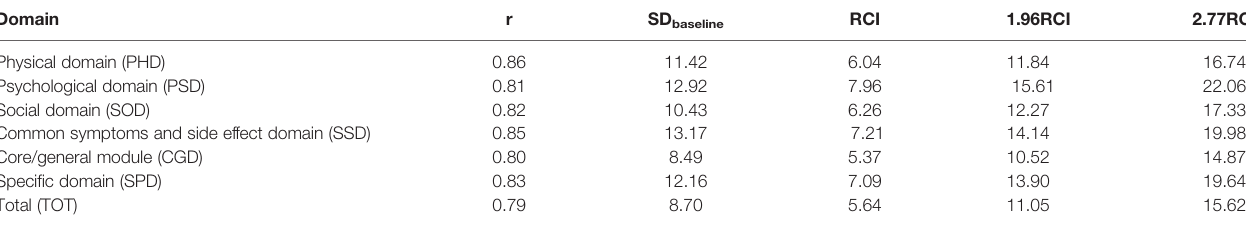
TABLE 6 | The MCID value of QLICP-BR (V2.0) determined by RCI (n =